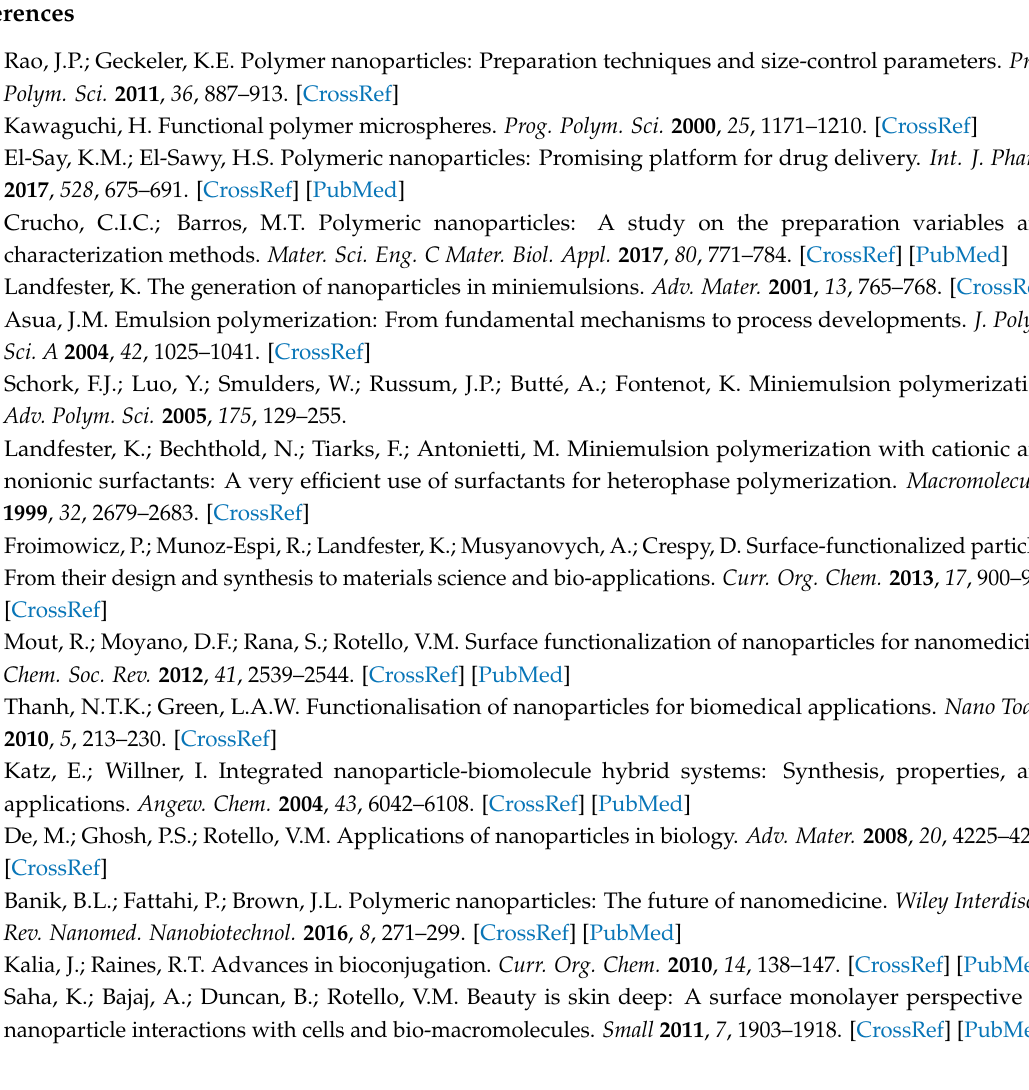
Figure S1 . 1 H-NMR spectrum of AUPDS surfmer; Figure S2. ATR-FTIR spectrum of AUPDS surfmer; Table S1. Example of reagent amounts for the preparation of particles via mini-emulsion polymerization using the AUPDS surfmer. Table S2. Z-average, PI and ZP values obtained for different particle syntheses using AUPDS 2 mol% and cross-linker (if present) at 10 mol%. Table S3. Z-average, PI and ZP values obtained for AUPDS-functionalized particles under different storage